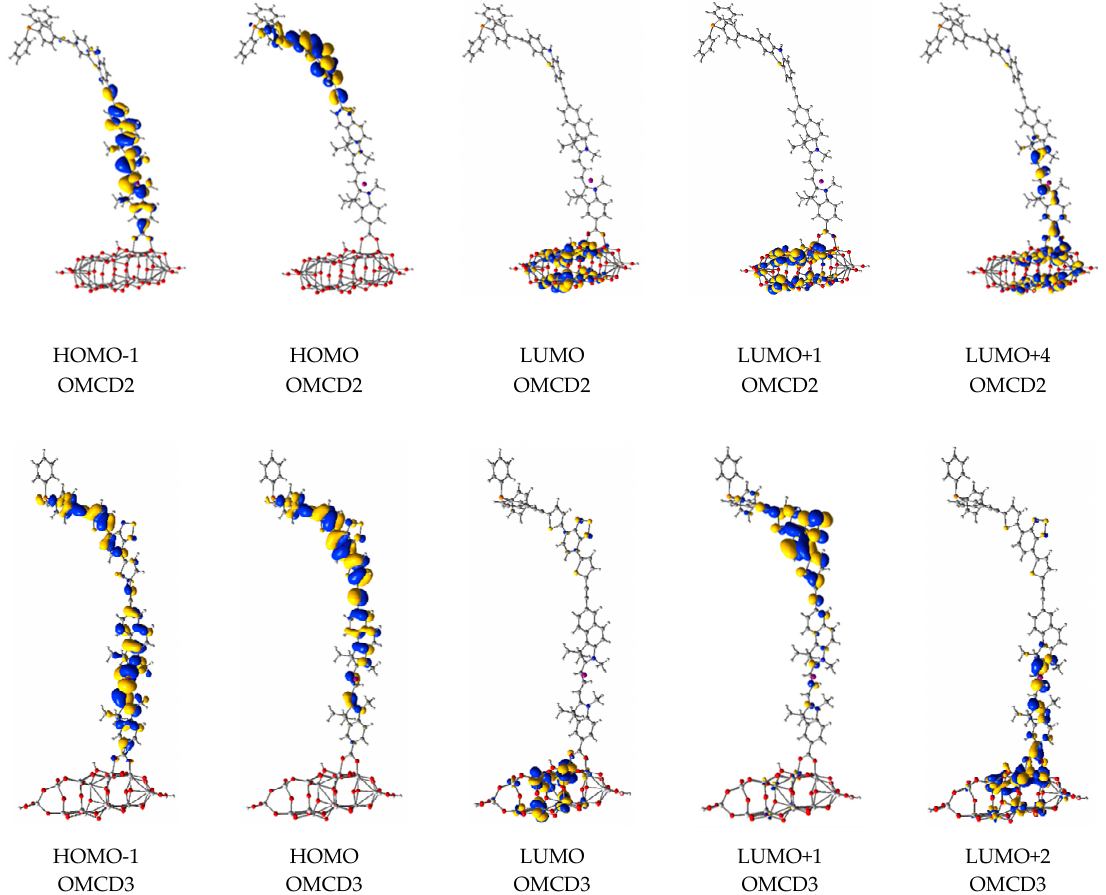
Figure 8. Isodensity surfaces (0.03 e / bohr 3 ) of the key molecular orbitals of the OMCD2 / Ti 24 O 50 H 4 and OMCD3 / Ti 24 O 50 H 4 complex systems, calculated by DFT at B3LYP / DZVP level in ethanol.